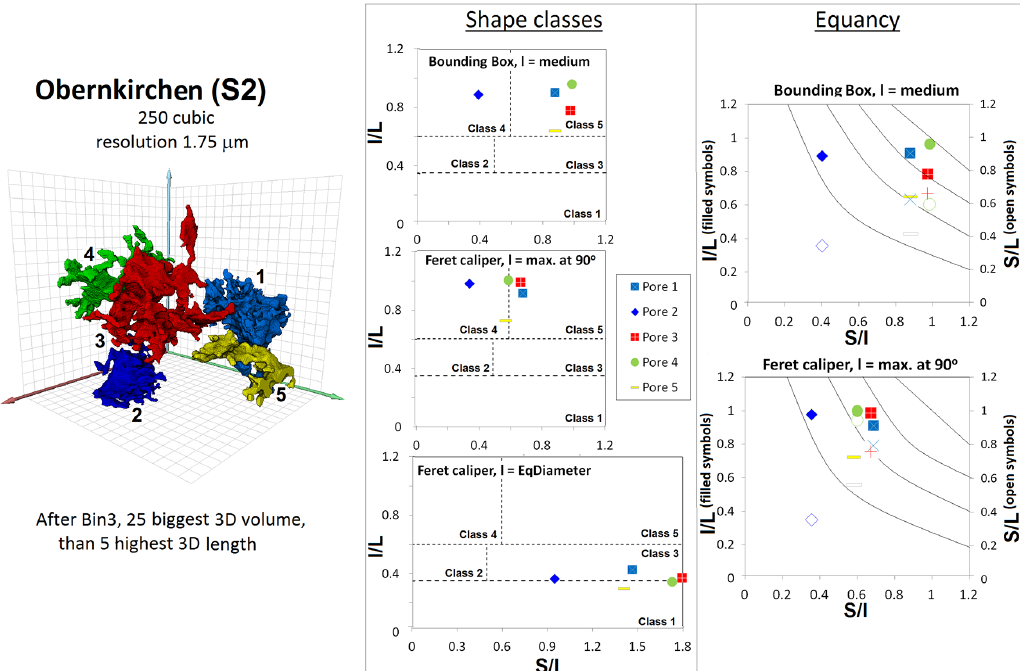
Figure 8. Pore shape results (S 2 ) of equancy and shape classes based on distinct descriptors for the five categorized pores in a 250 3 voxel volume. The lines shown in the graphics delimitate distinct particles shapes, as described in Fig. 2.